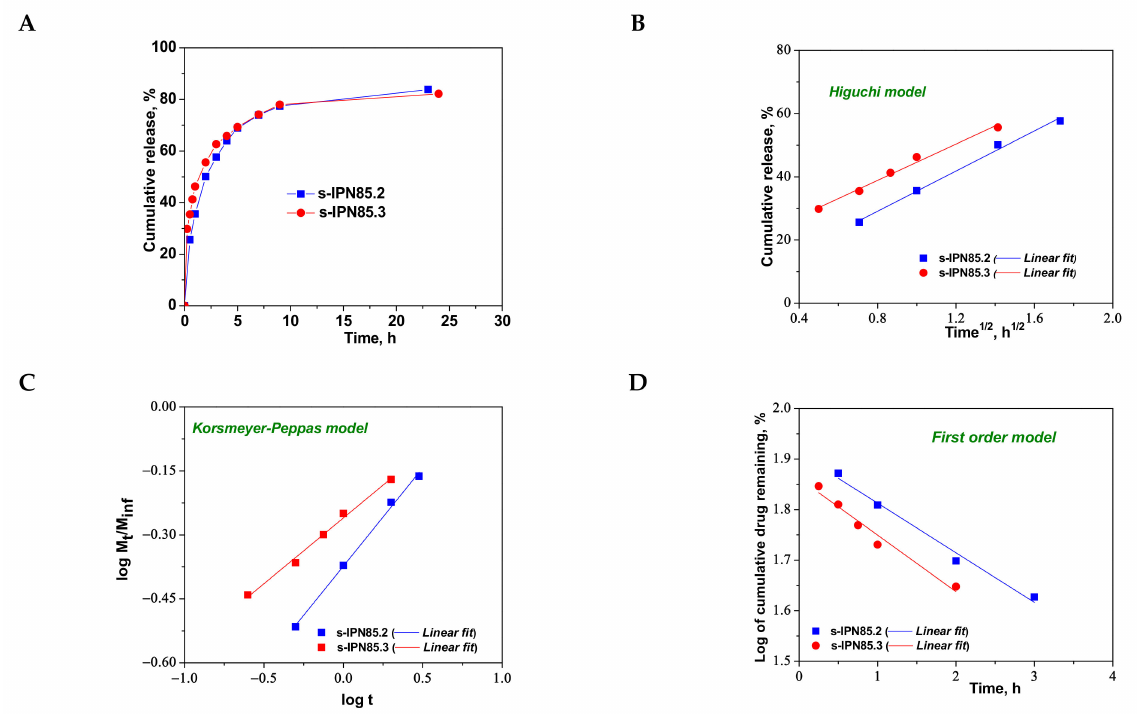
Figure 9. Cumulative release of CCM at pH 3.0, and 37 ◦ C, from semi-IPN with PDMAEMA85 entrapped in PAAm ( A ); fitting of kinetic models: Higuchi ( B ), Korsmeyer–Peppas ( C ), and first order ( D )